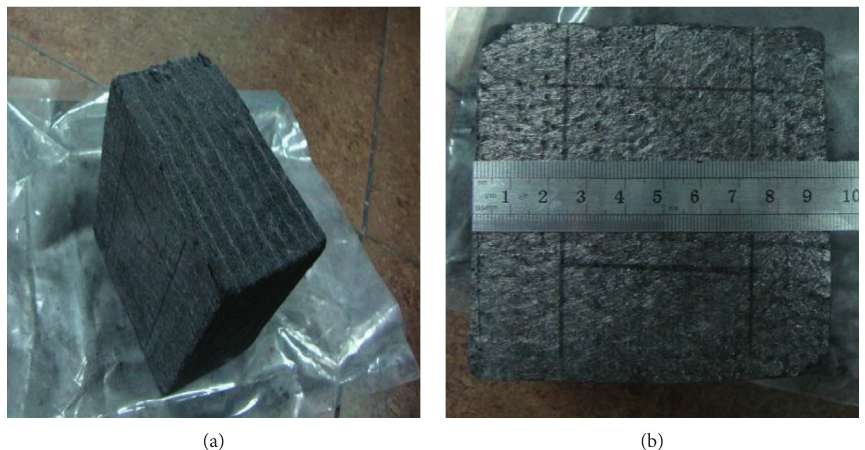
Figure 3: Carbon/carbon fiber composite resistivity test directions: (a) perpendicular to the plane direction; (b) plane